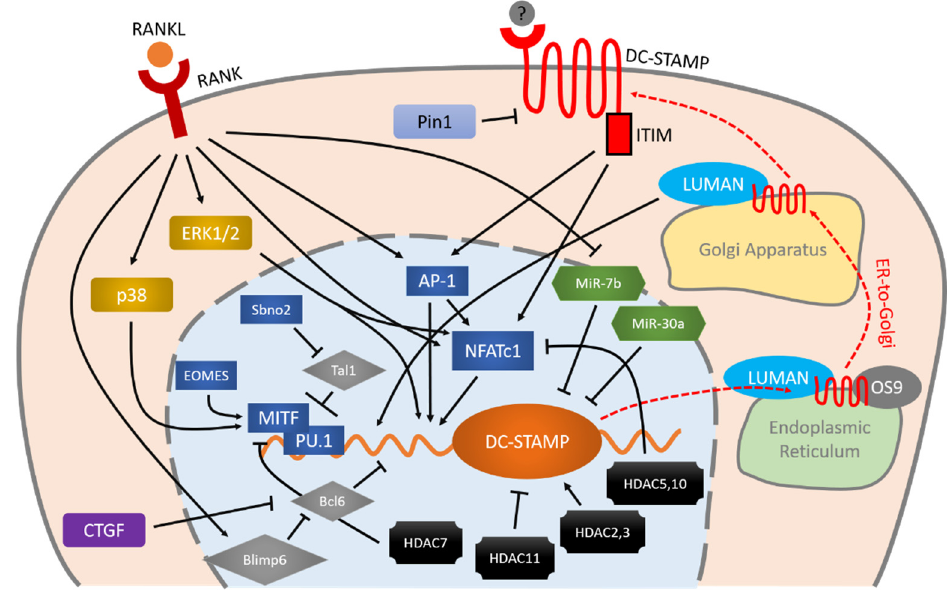
Figure 1. Schematic illustration of DC-STAMP regulation during osteoclastogenesis. RANKL-RANK is an important initiator of the expression of DC-STAMP via MAPK cascade, AP-1 and NFATc1. These two master transcription factors (AP-1 and NFATc1) and other factors including MITF, PU.1, Bcl6, and Blimp6 work together in a coordinated manner to control DC-STAMP with precision. Micro RNAs and HDACs also exhibit various effects on the regulation of DC-STAMP. Once the mRNA of DC-STAMP is translated into protein, it binds to LUMAN and OS9 for ER-to-Golgi transportation and eventually reaches the plasma membrane. Signaling through the ITIM that exists at the intracellular tail of DC-STAMP, conversely, regulates AP-1 and NFATc1 in a positive direction, further enhancing osteoclast differentiation and multinucleation. Arrows indicate positive regulation, bars indicate negative regulation, and red dashed arrows indicate intracellular transportation of DC-STAMP.